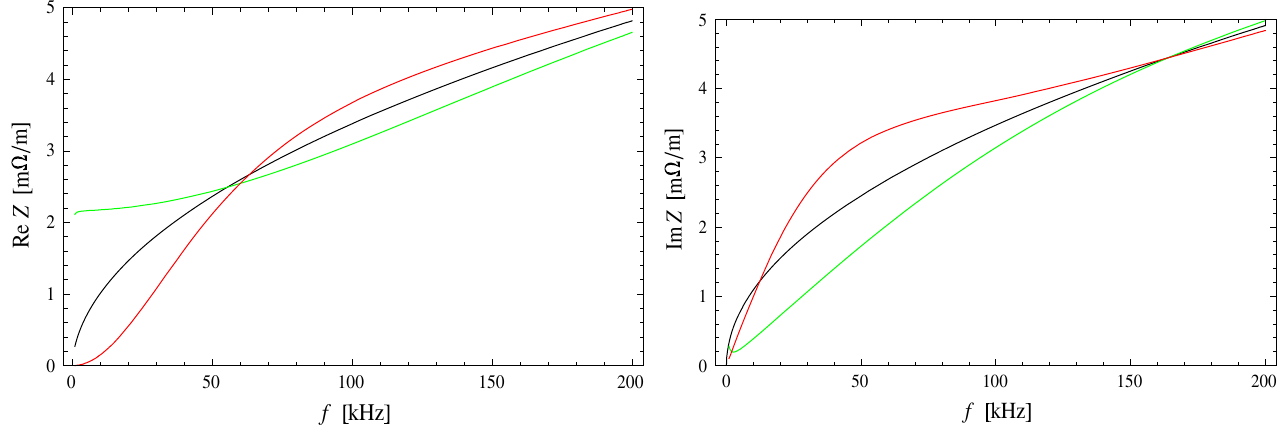
FIG. 3. Longitudinal impedance per unit length of a 2 mm thick thickness stainless-steel beam tube with (cid:4) ¼ 1 : 5 (cid:1) 10 6 = (cid:3)m and a b ¼ 23 : 5 mm radius [16], in red, green, and black, respectively, for the axial, radial, and unbound model.